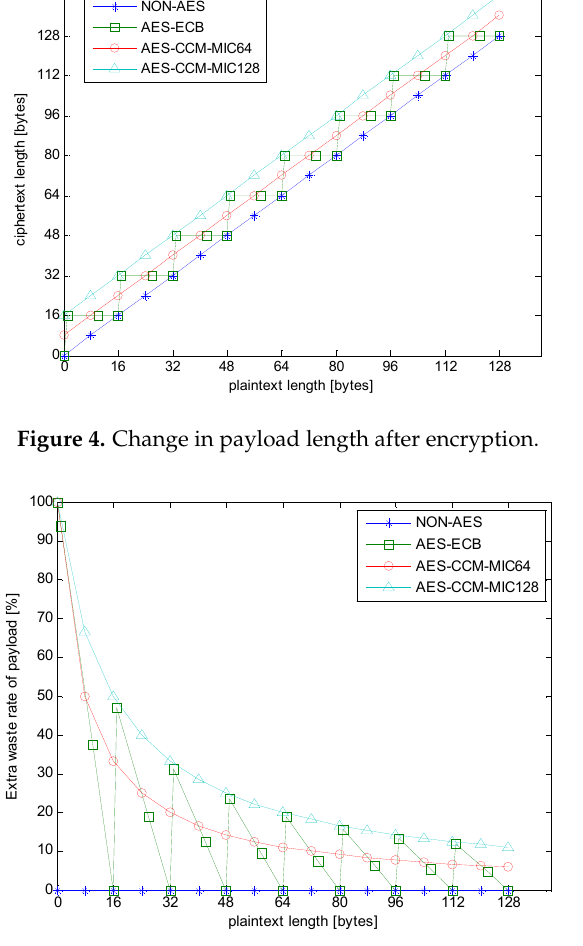
Figure 5. Extra payload waste rate of encryption.